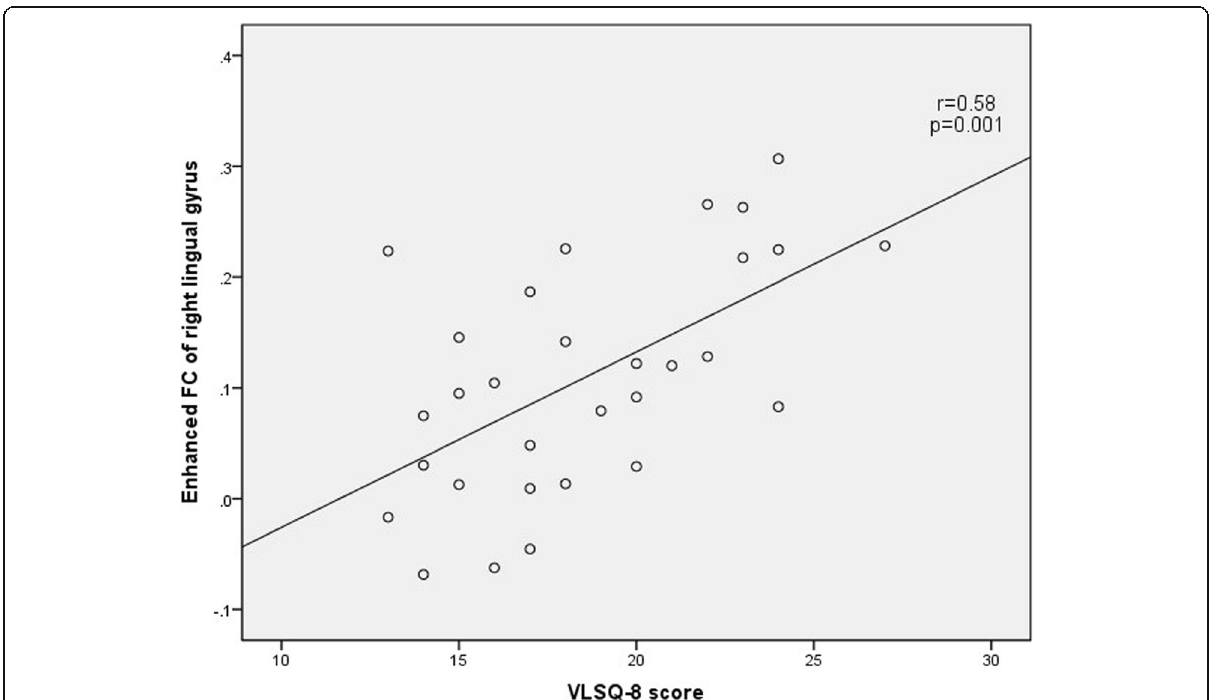
Fig. 4 The correlation of the VLS score with the enhanced FC of right lingual gyrus in MwoA compared with